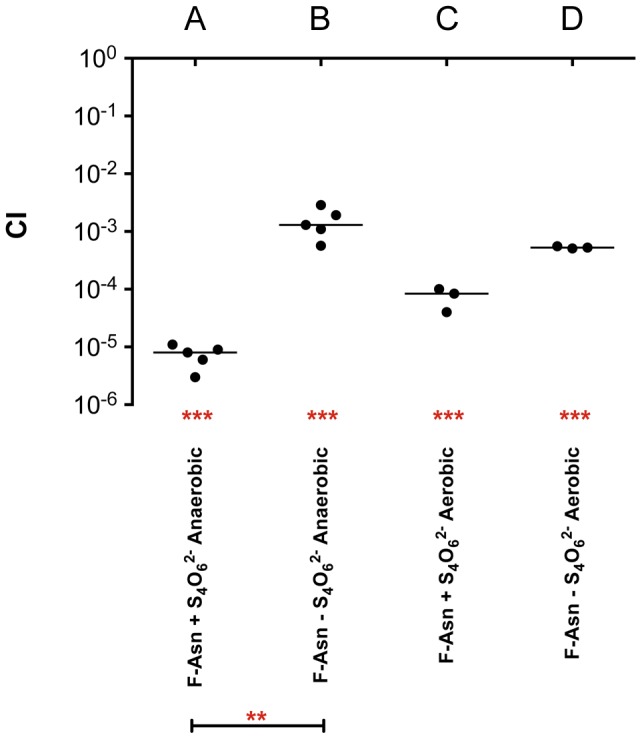
Competitive index measurements of a fraB1::kan mutant during in vitro growth.Cultures were grown overnight in LB, pelleted and washed in water, subcultured 1∶10,000 and grown for 24 hours at 37°C in NCE minimal medium containing 5 mM F-Asn, aerobically or anaerobically, in the presence or absence of tetrathionate (S4O6
2−), as indicated. A) Anaerobic growth in the presence of tetrathionate, B) anaerobic growth in the absence of tetrathionate, C) aerobic growth in the presence of tetrathionate, D) aerobic growth in the absence of tetrathionate. Each data point represents the CI from one culture with the median shown by a horizontal line. Statistical significance of each group being different than 1 was determined by using a one sample Student's t test. Statistical significance between select groups was determined using a Mann-Whitney test. ** = P value<0.01, *** = P value<0.001.